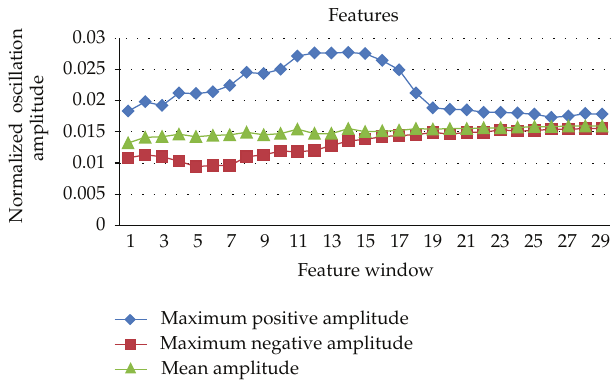
Figure 3: Features extracted with mean amplitude and maximum positive and negative amplitudes in the segmented feature windows from one subject.